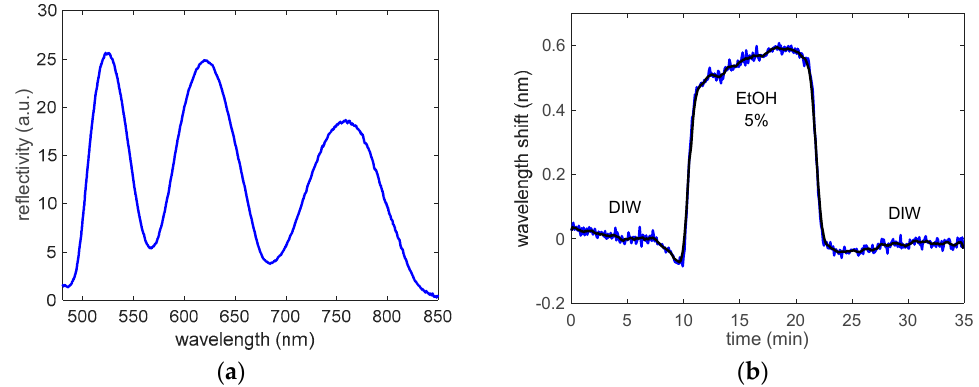
Figure 4. ( a ) Initial spectrum of the P123-templated mesoporous TiO 2 tri-layer in DIW. ( b ) Spectral shift of the interference maximum of the reflection spectrum located at 620 nm when a concentration of 5% EtOH in DIW was flowed through the porous sensor. The raw sensing curve is depicted in blue color and the averaged sensing curve is depicted in black color.